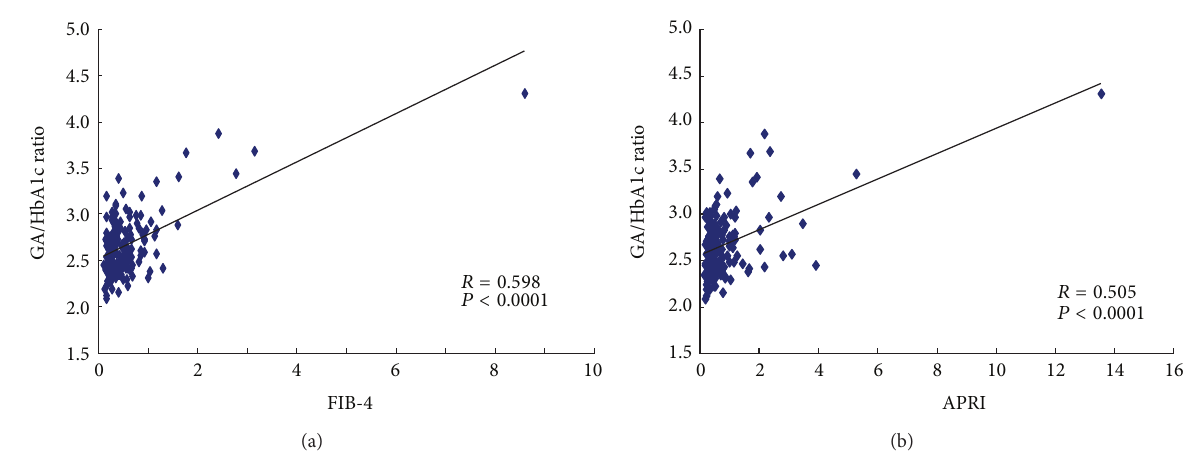
Figure 2: The correlation of the GA/HbA1c ratio with other fibrosis-related biomarkers. The GA/HbA1c ratio was correlated with the FIB-4 and APRI. APRI: AST-to-platelet ratio